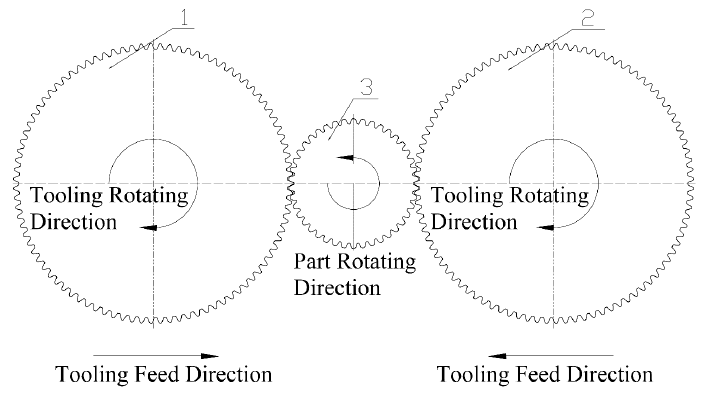
Figure 1. Schematic diagram of the densification of the rolling surface. 1 and 2: Rolling tool; 3: Sample.